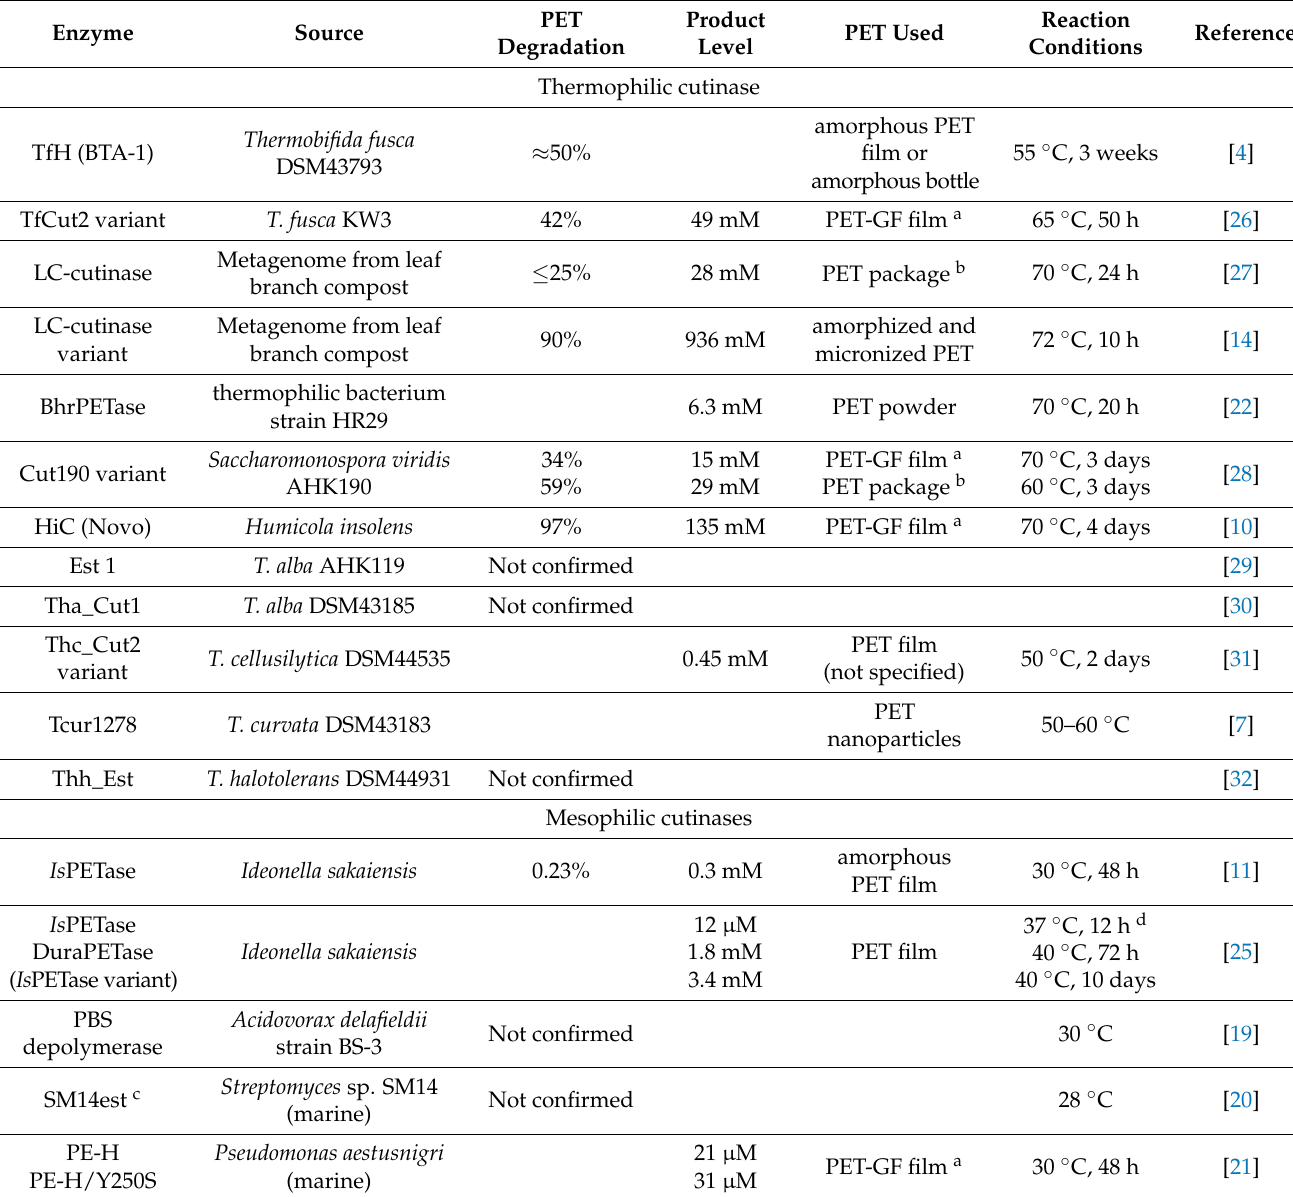
Table 1. Comparison of thermophilic and mesophilic polyethylene terephthalate (PET) hydrolases and their